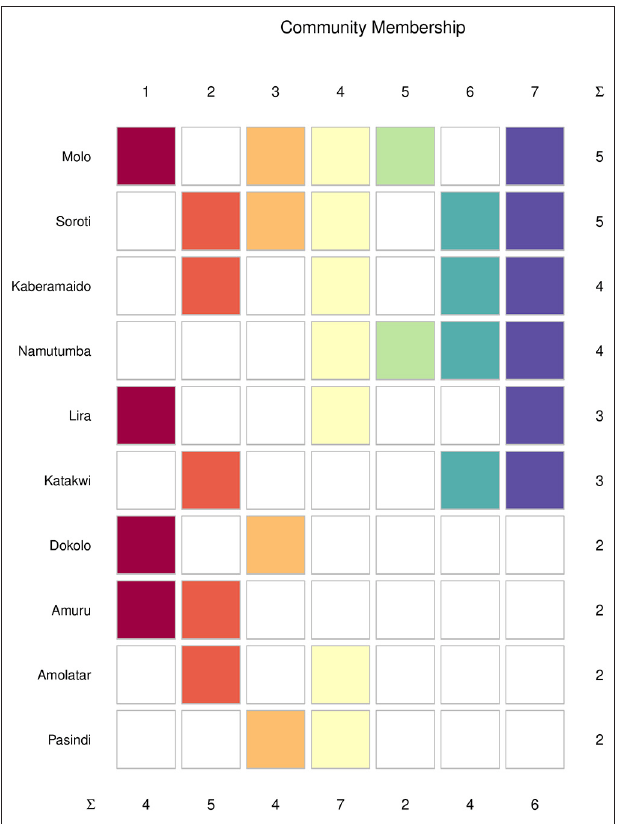
FIGURE 8 | Community membership of the top (most) connected cattle markets in southeast and northwest. Colors indicate the community-specific membership, and the N-Ary summation ( P ) shows the total number of cattle markets in each community.